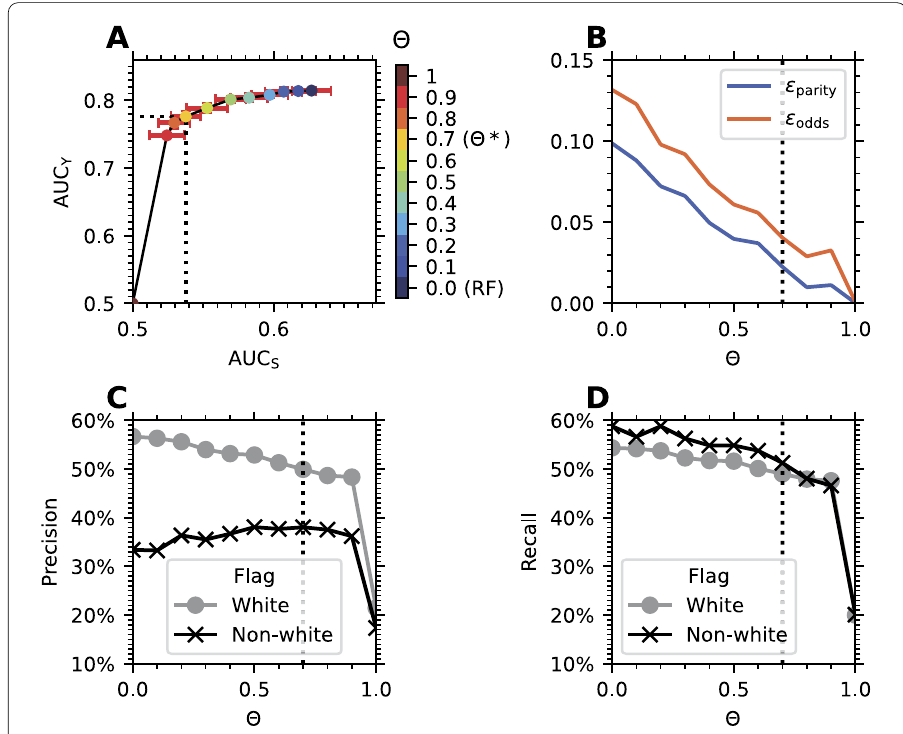
Figure 3 ( A ) The performance of the fair random forest classifier for different values of the orthogonality. ( B ) The fairness performance measured in demographic parity and equalised odds for different values of (cid:2) . ( C )–( D ) The performance measured in precision ( C ) and recall ( D ) for different values of (cid:2) , separated for ships flying a white and non-white